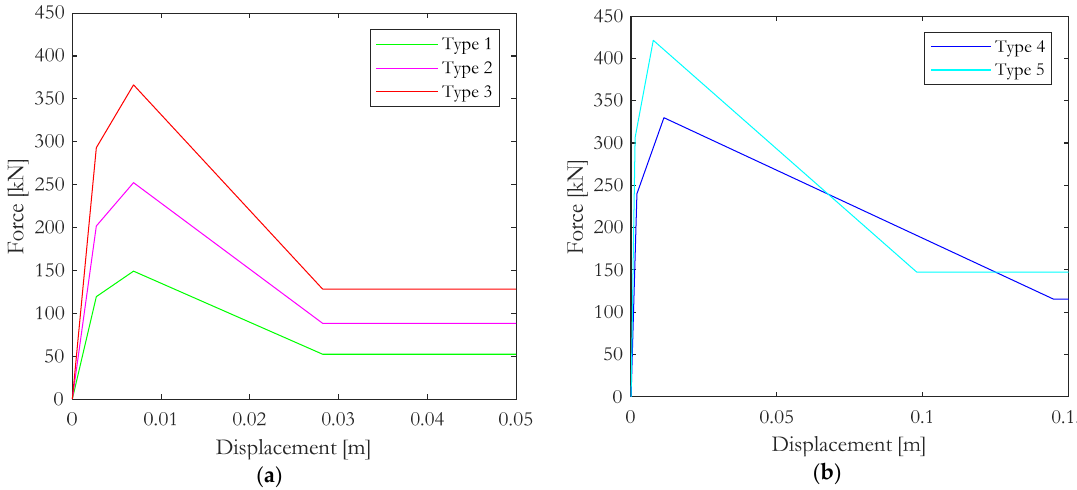
Figure 12. Backbone curves ( a ) for masonry infill type 1-2-3 according to Tables 3 and 4 and ( b ) for masonry infill type 4-5 according to Tables 3 and 4.